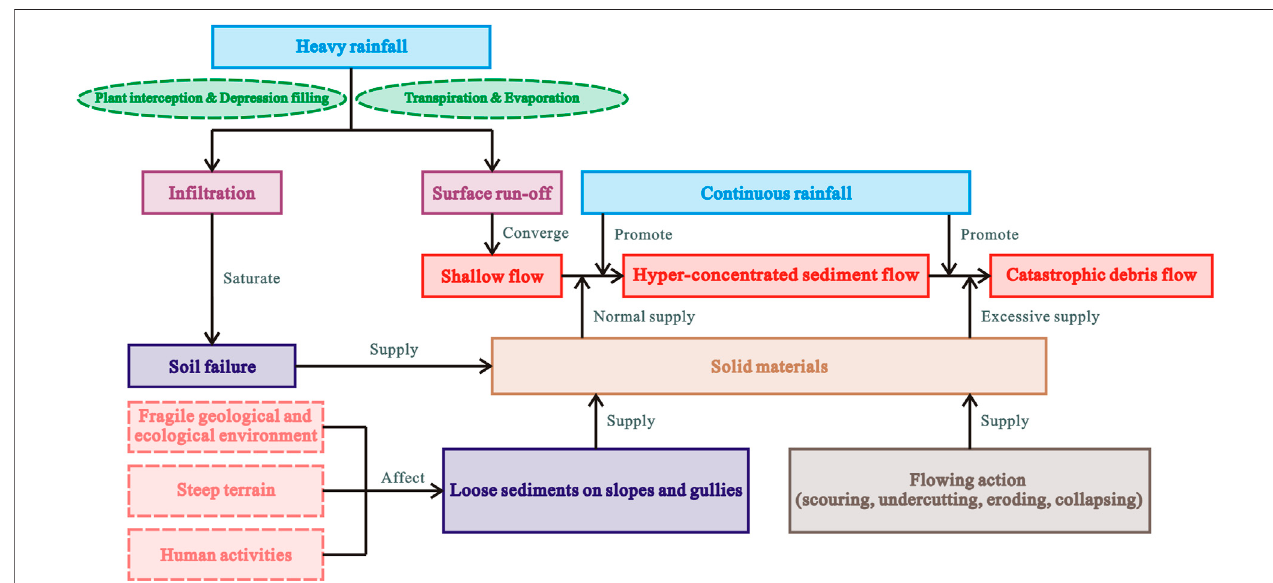
FIGURE 6 | Analysis of the formation and dynamic evolutionary mechanism of the debris fl ow disaster in southwestern China.